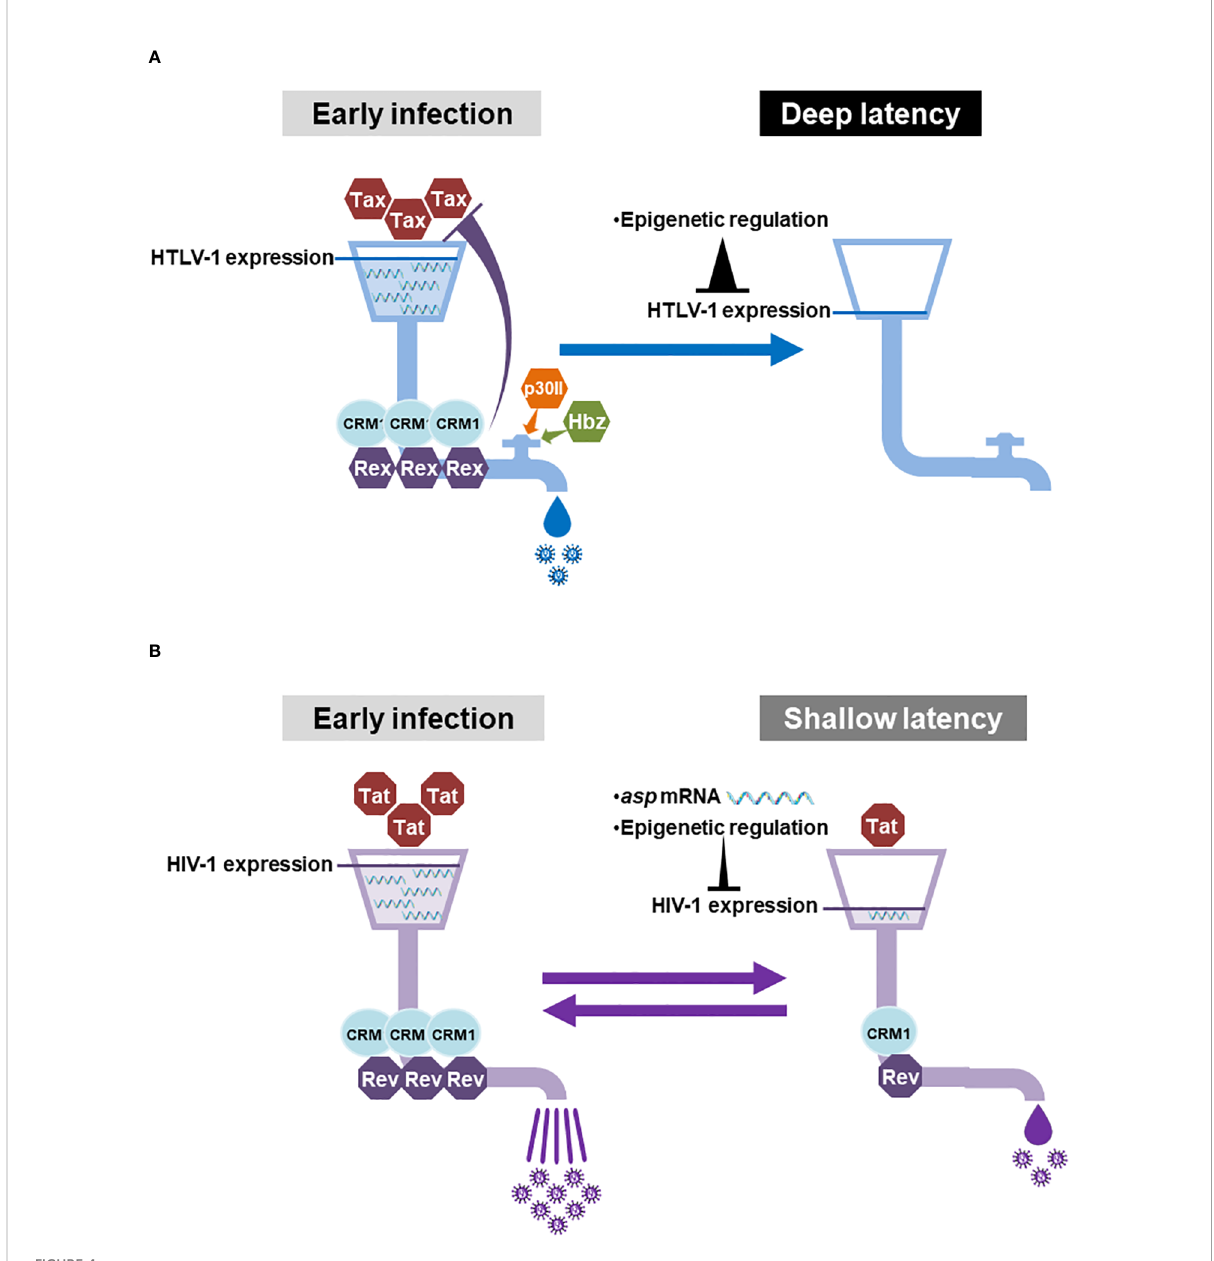
FIGURE 4 With or without the regulatory valve for HTLV-1-Rex and HIV-1 Rev and the regulation of the viral gene expression: (A) In the early HTLV-1-infected cells, Tax enhances the viral gene expression and Rex serves the “ pipeline ” of viral mRNAs between the site of transcription and the translational machinery. Since the “ fl ow rate (Rex activity) ” of the Rex pipeline is controlled by the “ regulatory valve ” , which is composed of Rex itself, Hbz, and p30II, the viral mRNAs transcribed by Tax are not all translated directly into viral particles. In the latent state, the 5 ′ LTR (as L.545) is heavily methylated universally, therefore the expression of Tax and Rex is completely shut-down in almost all infected T cells. Such strict regulation of viral gene expression may allow the infected cells sustain the disease-free deep latency for decades. (B) In HIV-1 infected cells, Tat is responsible for viral gene expression and Rev also serves as the pipeline of the viral mRNAs. In contrast to HTLV-1, there is no regulatory valve, which controls the activity of Rev. Therefore, the viral mRNAs transcribed by Tat are expected to be translated as is to produce a vast number of viral particles from an early infected cell. Asp mRNA and methylation of 5 ′ LTR (as L.545) serve to suppress viral gene expression during the latency. However, the methylation in the 5 ′ LTR (as L.545) does not occur universally, allowing some reservoir cells